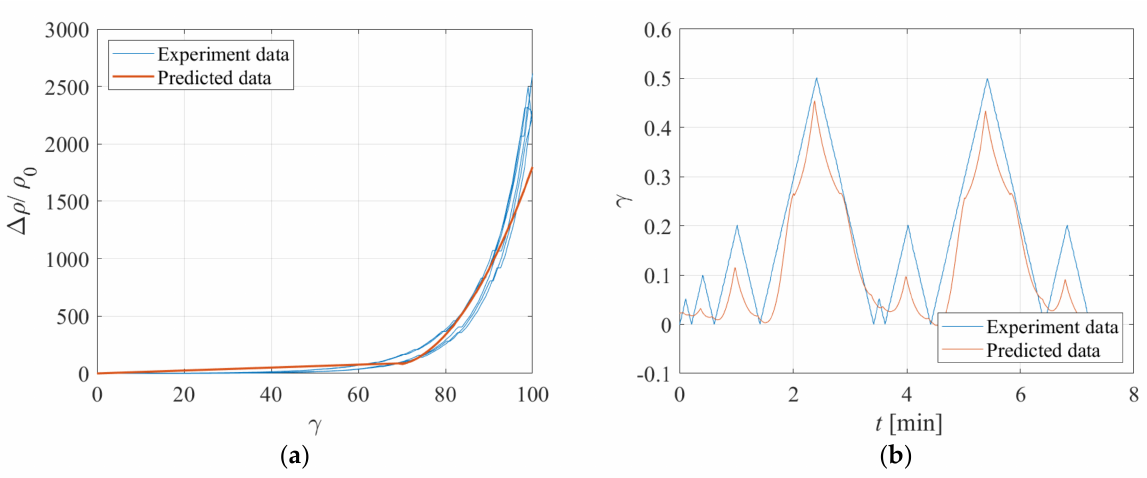
Figure 20. Comparison between experiment and predicted data: ( a ) Variation of resistance vs. strain, ( b ) Strain vs.